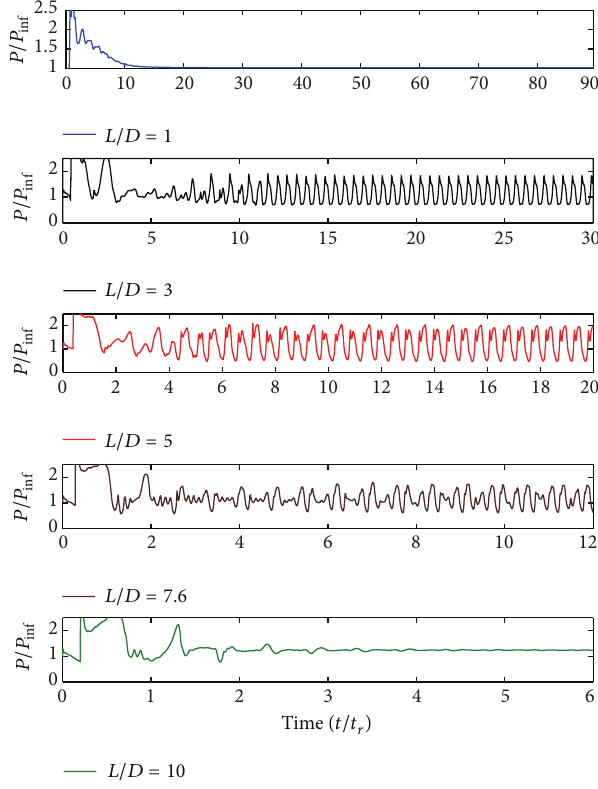
Figure 4: Pressure time history of the aft bulkhead at y/D =